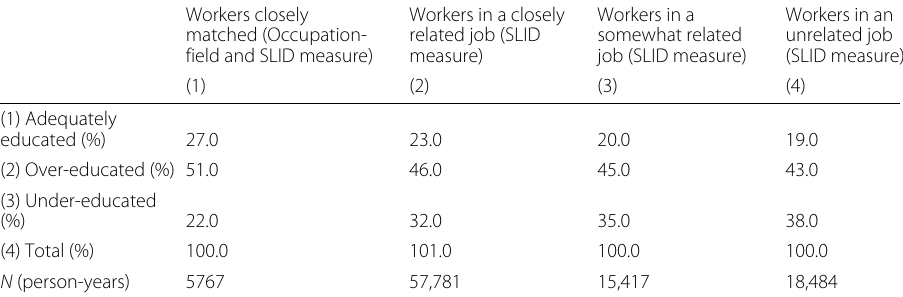
Table 18 Distribution of quantitative match by self-reported SLID match variable (males and females) Workers closely Workers in a closely Workers in a Workers in an matched